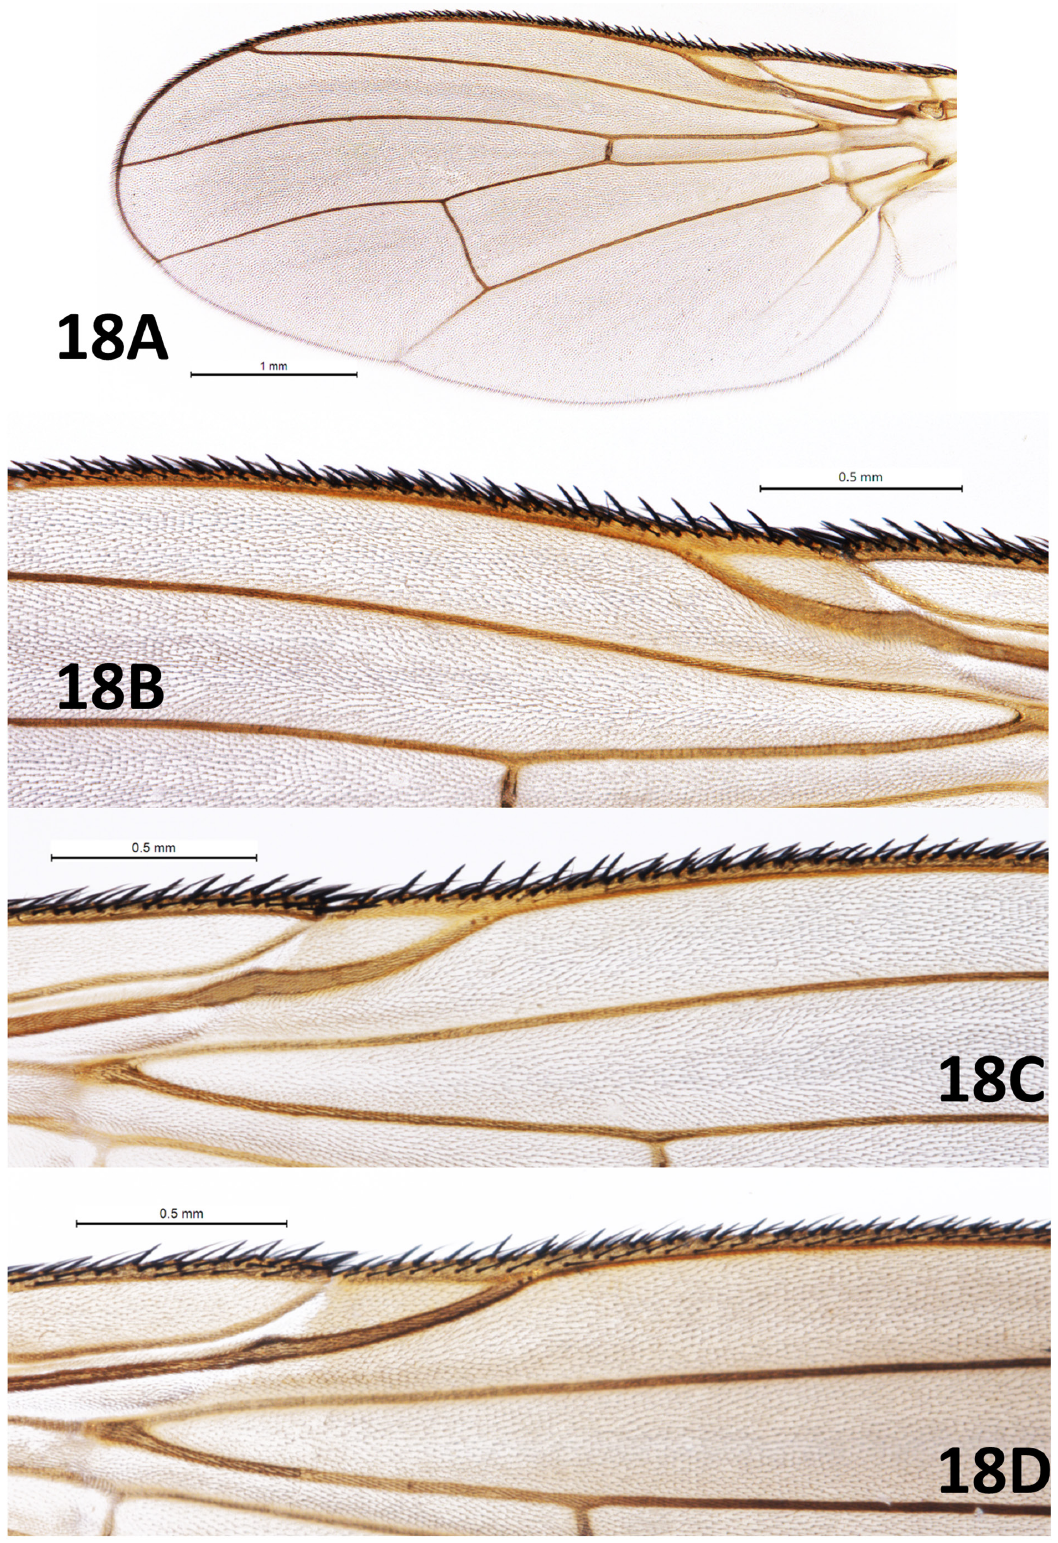
Fig. 18. ♀♀ of Coenosia Meigen, 1826. A . C . intermedia (Fallén, 1825), wing, ventral view. B . Same, detail of wing showing CS1‒3, ventral view. C . Same, detail of wing showing CS1‒3, dorsal